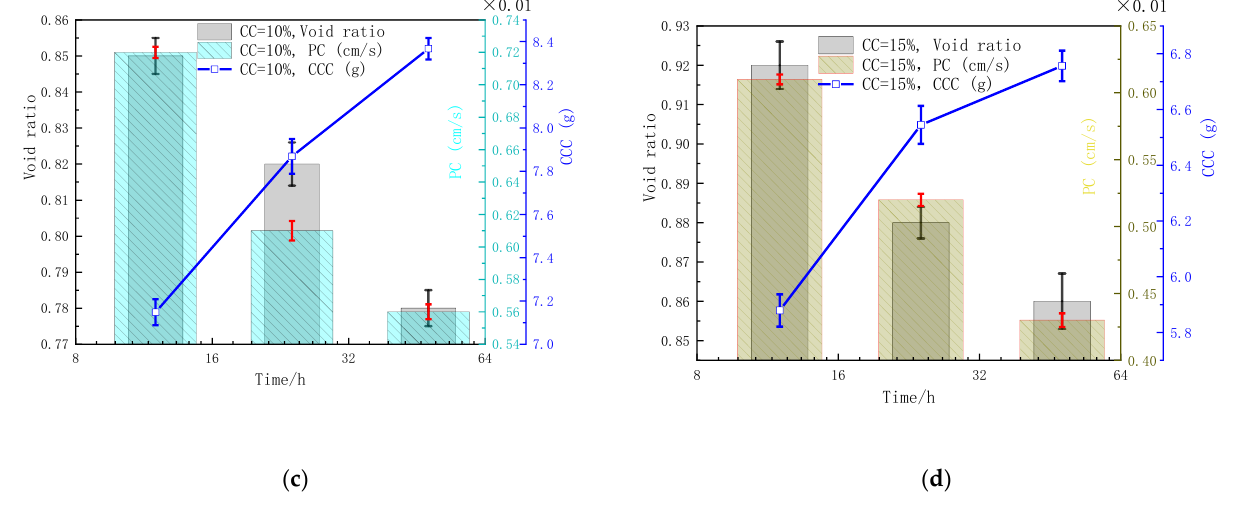
Figure 9. Influences of CC on the void ratio, permeability, and CCC. ( a ) CC = 0. ( b ) CC = 5%. ( c ) CC = 10%. ( d ) CC = 15%.